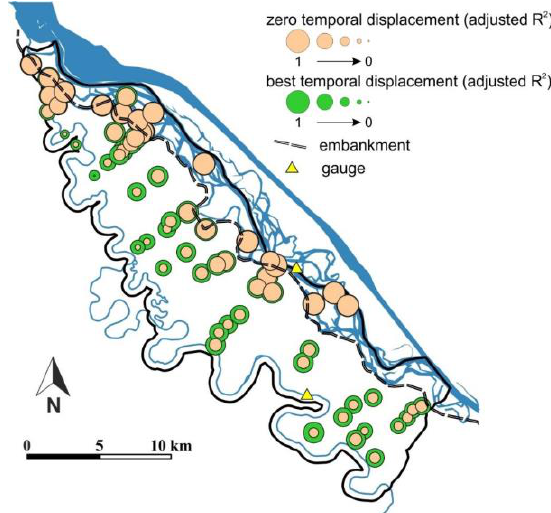
Figure 6. Spatial distribution of adjusted R 2 values, demonstrating that the temporal displacement of the water level is crucial, especially on the protected side, to achieve better modeling. The radius of the circles is in proportion to the adjusted R 2 values.